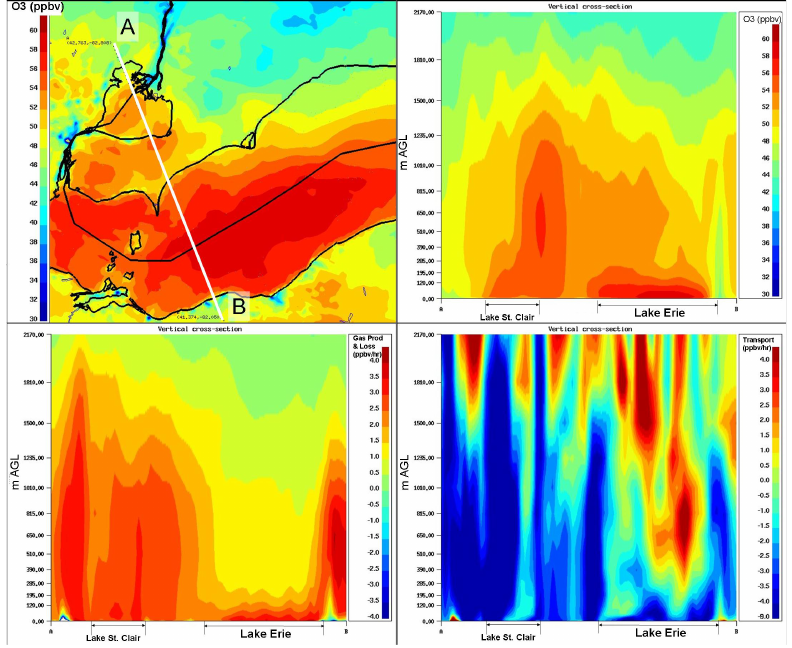
Fig. 19. 23-day average values at 20:00 UT (04:00 p.m. local time): (a) surface ozone over Lake St. Clair and Lake Erie, showing location of cross-section used for (b) ozone concentration, (c) ozone gas-phase production and loss, (d) ozone total